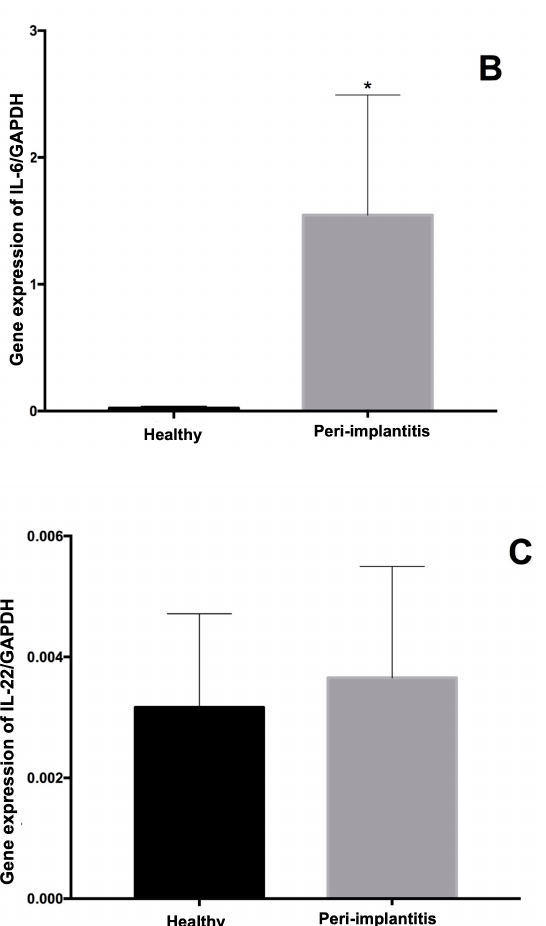
Figure 1. Gene expression levels of the transcription factor Aryl-hydrocarbon Receptor (AhR) ( A ), interleukin (IL)-6 ( B ), and IL-22 ( C ) according to the expression of the reference gene (GAPDH: glycerin-aldehyde-3-phosphate-dehydrogenase). * Statistically significant difference assessed using Mann–Whitney test ( p < 0.05).